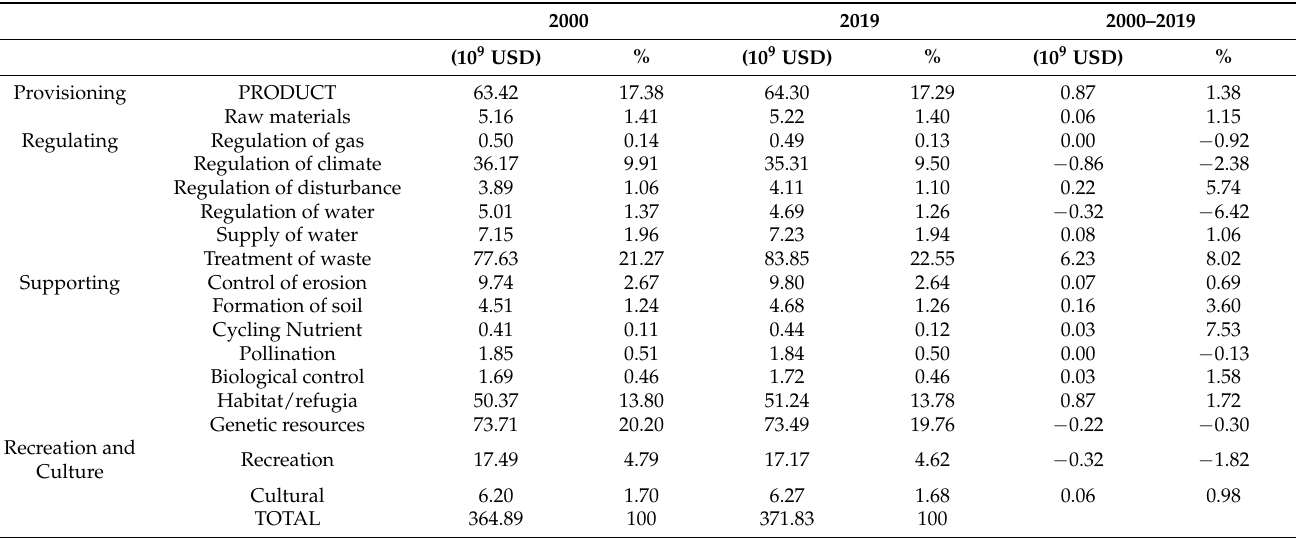
Figure 4. Spatial pattern of change in the rate of ecosystem services value (%) in different scales for the provinces ( a ), the regions ( b ), and towns ( c ) in Madagascar island from 2000 to 2019. Table 7. Estimated values for diverse ecosystem functions ( ESV f ) in Madagascar island from 2000 to